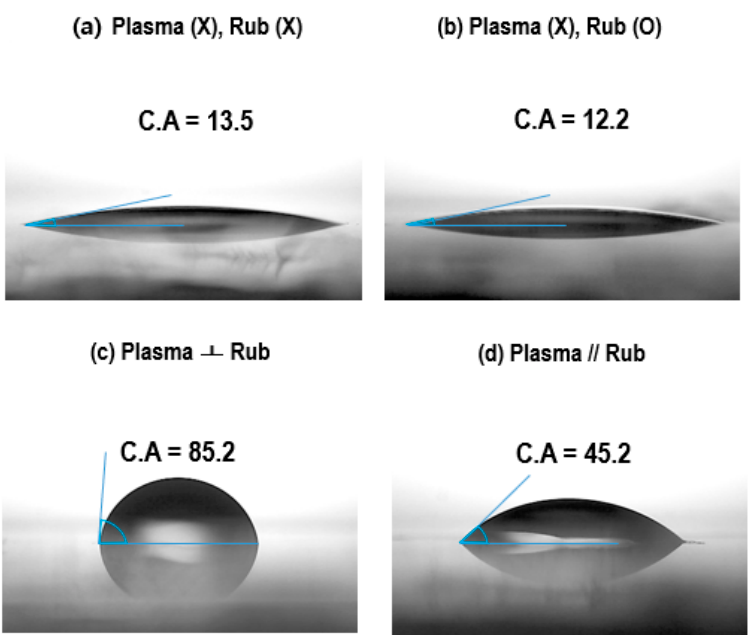
Figure 8. Captured image of the contact angle measurements on the PVA-coated surface. ( a ) No plasma treatment and no rubbing, ( b ) no plasma treatment and rubbing, ( c ) plasma treatement perpendicular to the rubbing, ( d ) plasma treatment parallel to the rubbing.